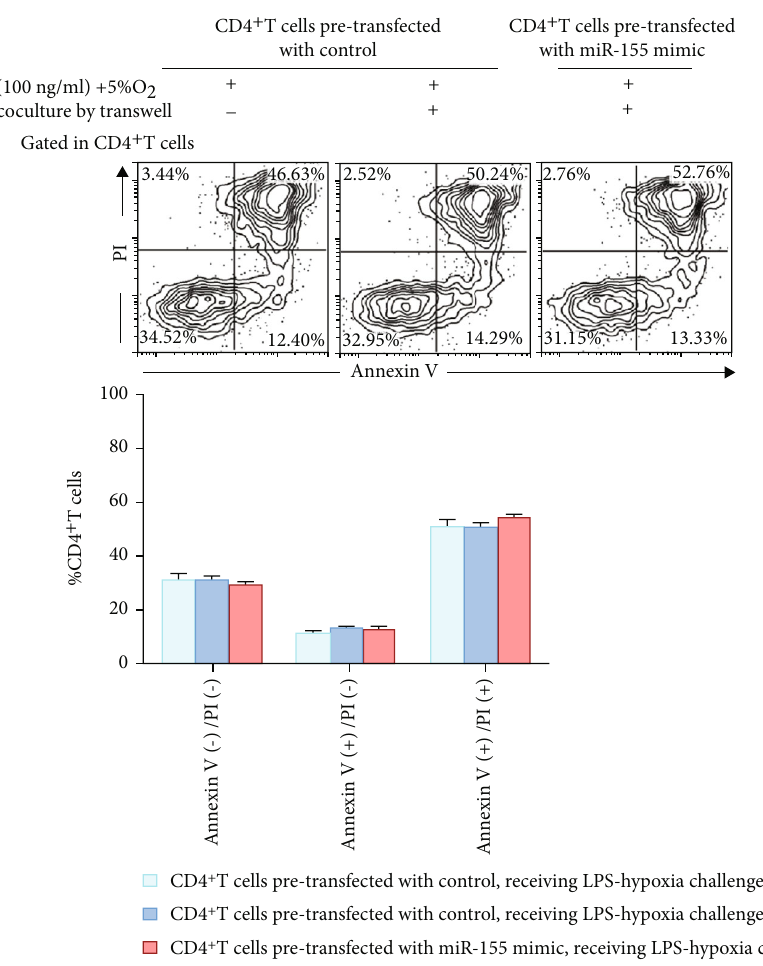
Figure 7: E ff ects of miR-155 overexpression in CD4 + T cells on apoptosis upon LPS-hypoxia challenge in response to MSC treatment. CD4 + T cells pretransfected with control/miR-155 mimic received MSC treatment by transwell system, with/without LPS-hypoxia challenge for 48 hours. Then, cells were harvested for apoptosis assay with Annexin V/PI staining by fl ow cytometry. Representative fl ow plots were shown. Bar graphs represent mean frequency ± SEM of living (Annexin V(-)/PI(-)), early apoptosis (Annexin V(+)/PI(-)), and late apoptosis and dead (Annexin V(+)/PI(-)) percentage of CD4 + T cells in the various groups. LPS: lipopolysaccharide; MSC: mesenchymal stem cell; SEM: standard error of the